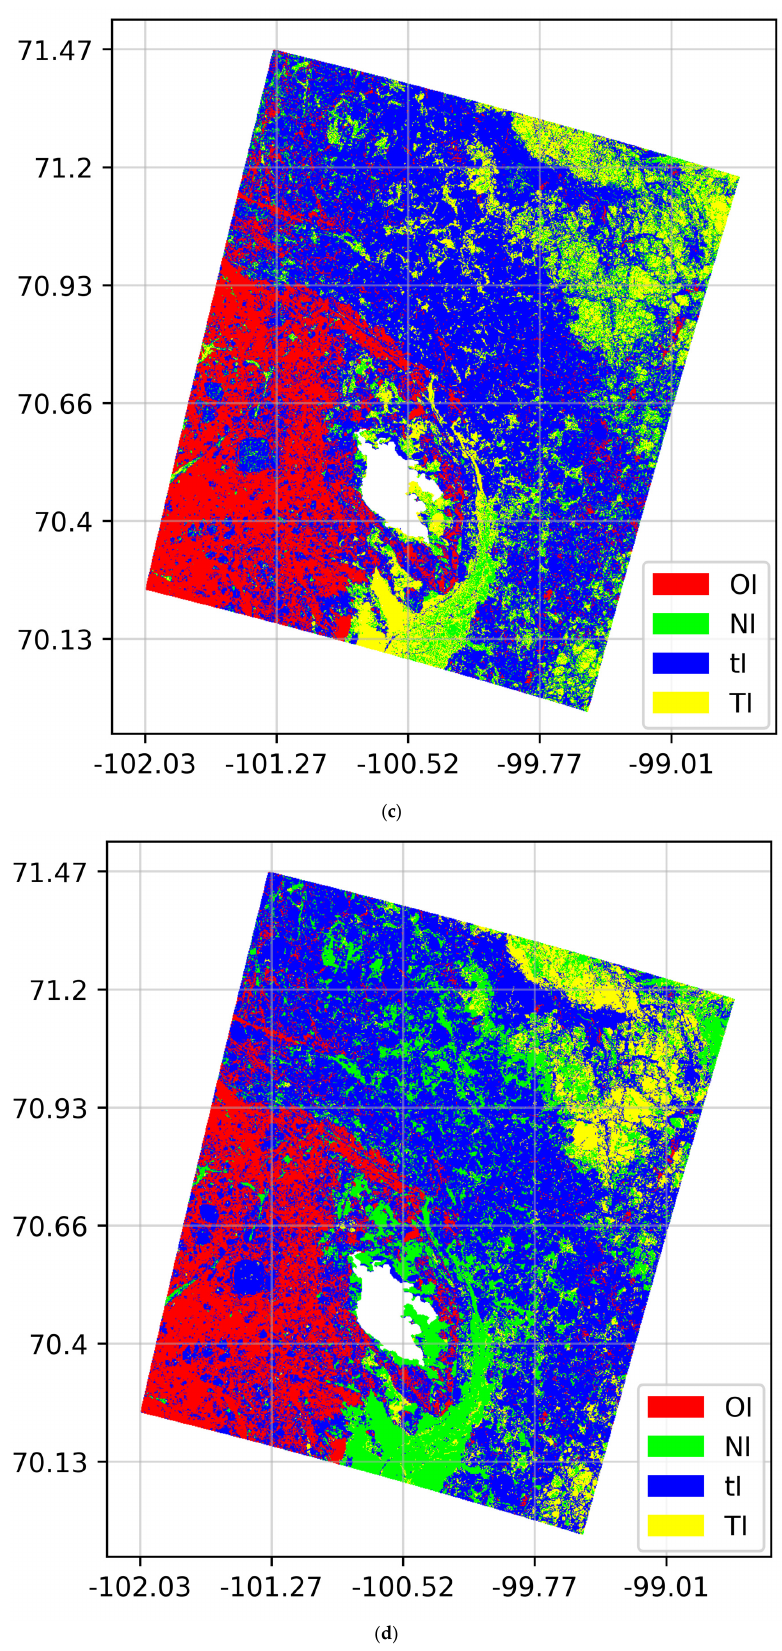
Figure 7. Sea ice classification results for ( a ) scene 19 using ( b ) VV polarization data, ( c ) VH polari- zation data, and ( d ) dual-polarization data. From the confusion matrix, it can be seen that the classification accuracies are 85.80%, 86.50%, and 95.85% for the three cases, respectively. When using dual-polarization data, the overall accuracy of classification using only VH polarization data is improved by 10.05% with kappa coefficient increased by 0.1363, and the overall accuracy of classifica- tion using only VV polarization data is improved by 9.35% with kappa coefficient in- creased by 0.1247. It can be concluded from the above comparison that the combined use of dual-polarization data can compensate for the lack of information when single-polari- zation data are used alone, allowing the classifier to learn more classification basis to im- prove the accuracy of classification results. The difference in overall classification accuracy between VH polarization data and VV polarization data is not significant. In terms of overall level, the numbers of features obtained by the model from these two types of data alone are roughly equivalent. Alt- hough the overall classification accuracy using single-polarization data is poor, there is still something to be said for the classification of single categories. For example, the clas- sification accuracy of NI using only VV polarization data reached 99.2%, and the classifi- cation accuracy of OI using only VH polarization data reached 97.2%.